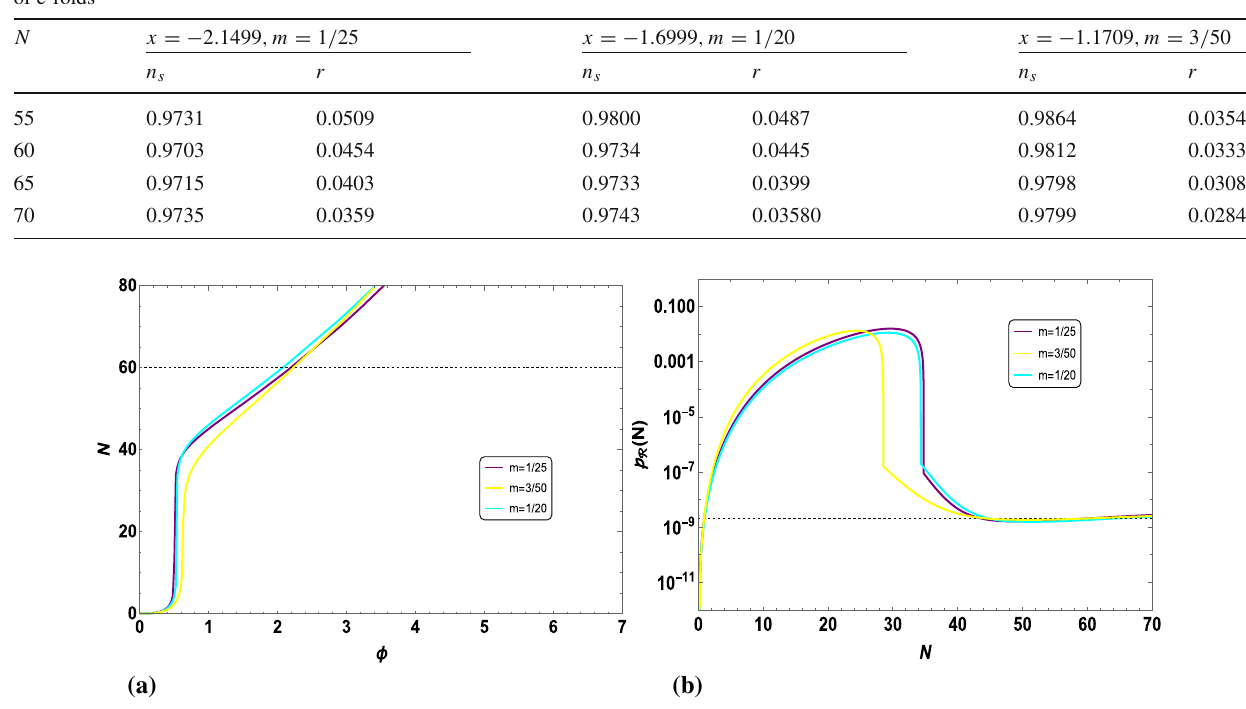
Table 3 For q = 1 and n = 1, Inflationary observables for the different values of the potential parameters ( x and m ) with variety of total number of e-folds